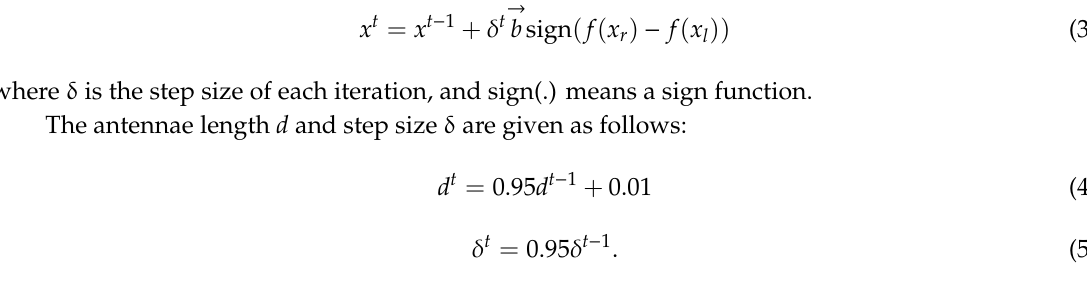
Table 1. The hyper-parameters of algorithms and definitions.